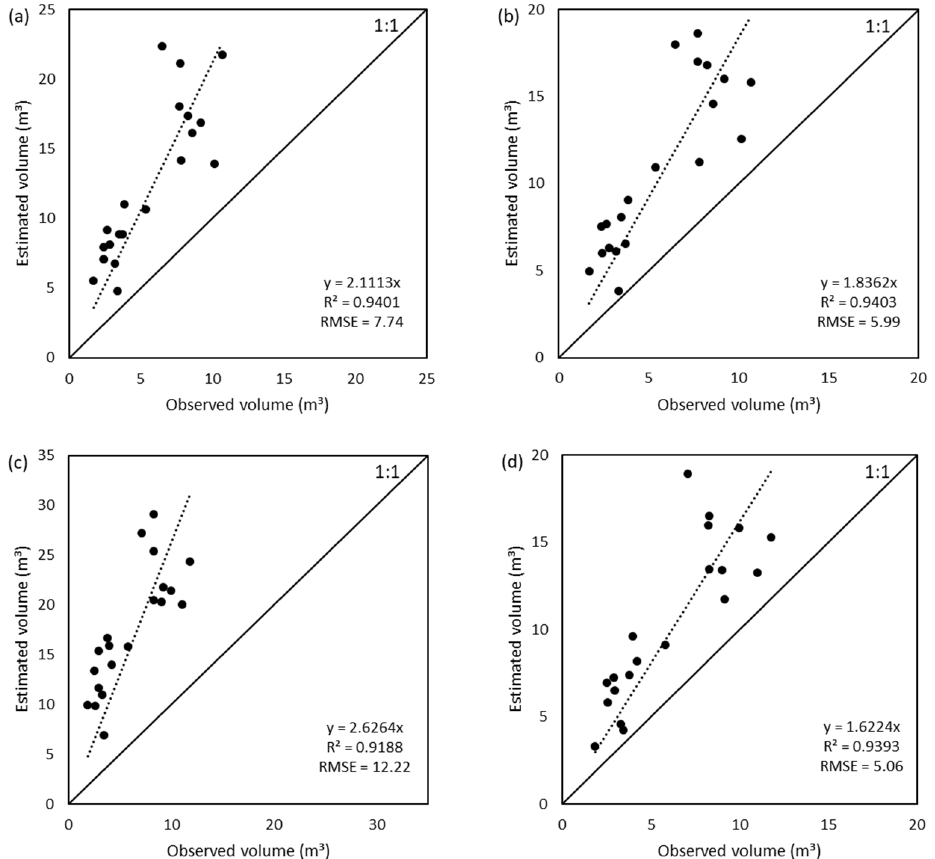
Figure 14. Scatter plot and linear fitting of the estimated volume vs. observed values (ground-truth), assuming the crown is an ellipsoid ( a , b ) and a sphere ( c , d ). Estimated values: ( a ) bounding box, ( b ) oriented rectangle, ( c ) circle, and ( d ) convex hull. Linear regression models with p < 0.05. The dashed line is the fitted linear function passing through the origin and the solid is the 1:1 line.